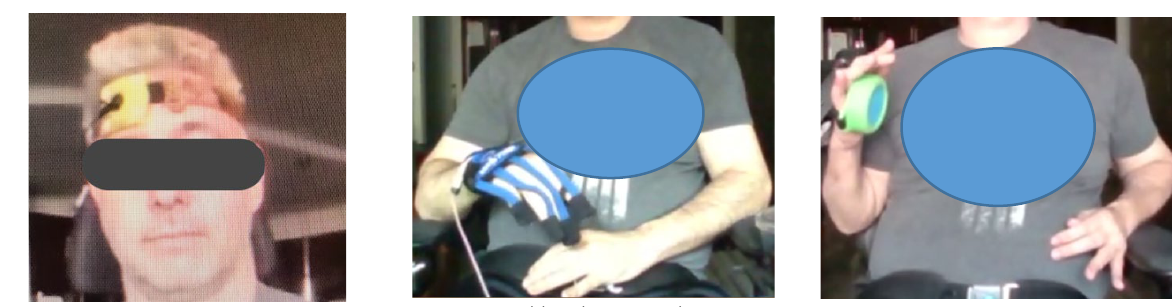
Repetitive Finger Exercises Repetitive Arm/Hand 1x1 electrode montage for stimulating M1 area with tDCS